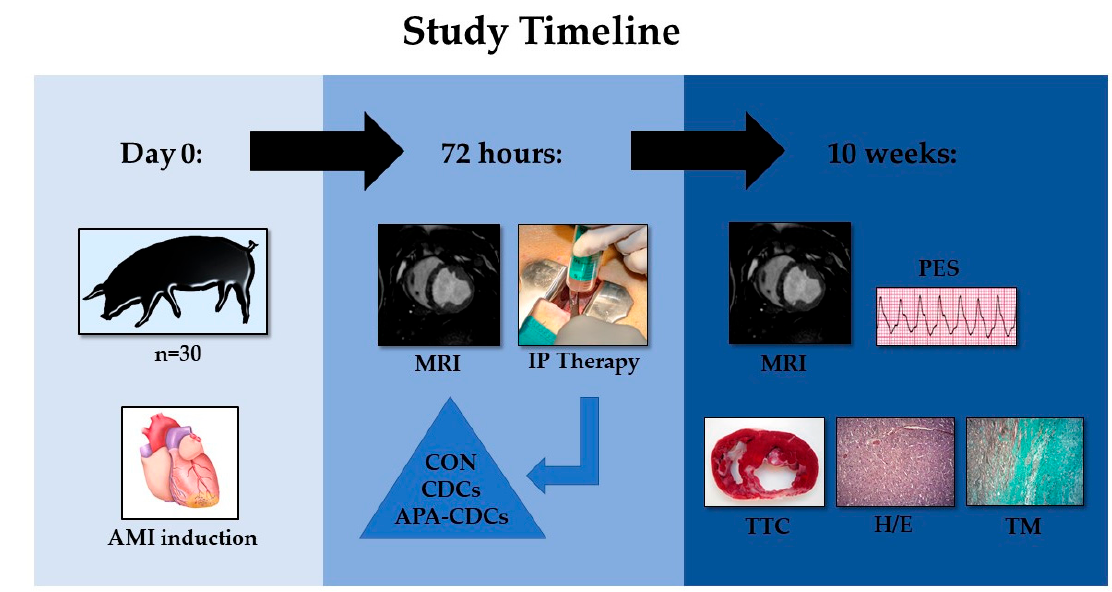
Figure 1. Timeline of the experimental study.